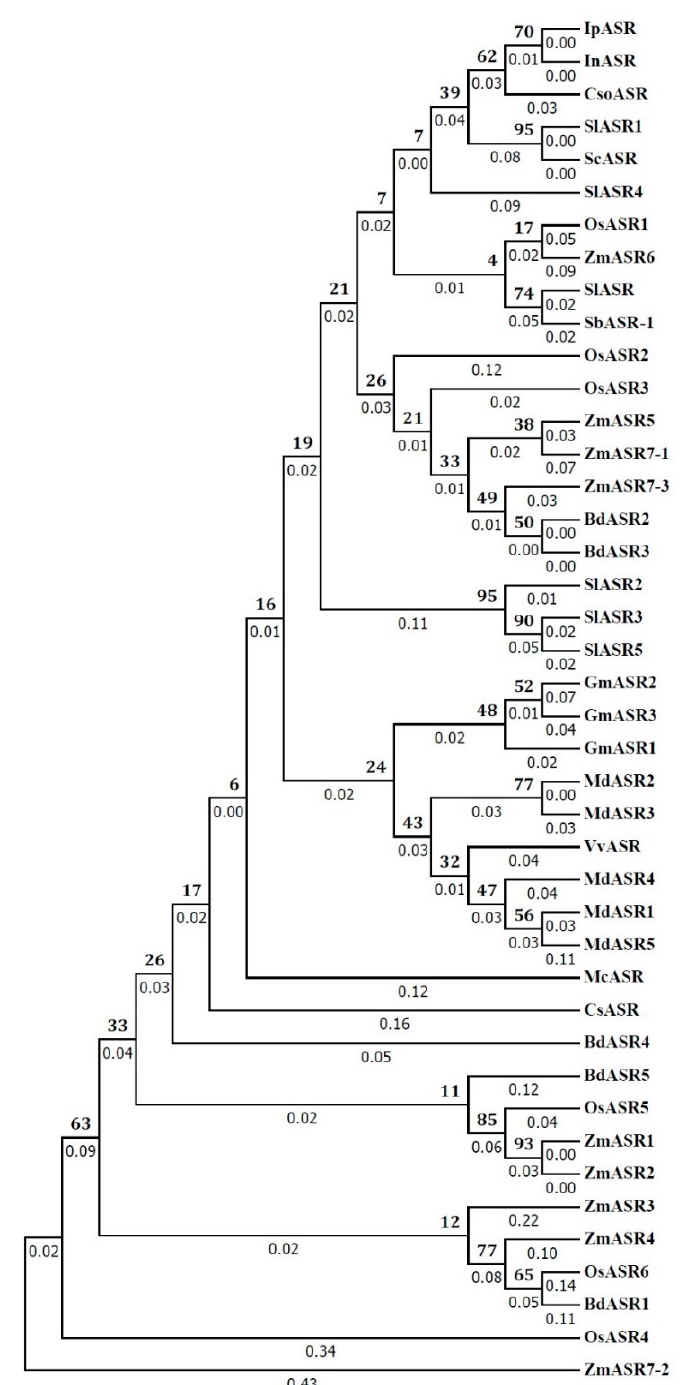
Figure 2. Phylogenetic analysis of IpASR with other ASR proteins. GenBank accession numbers are listed in the “Materials and Methods” (Section 4).